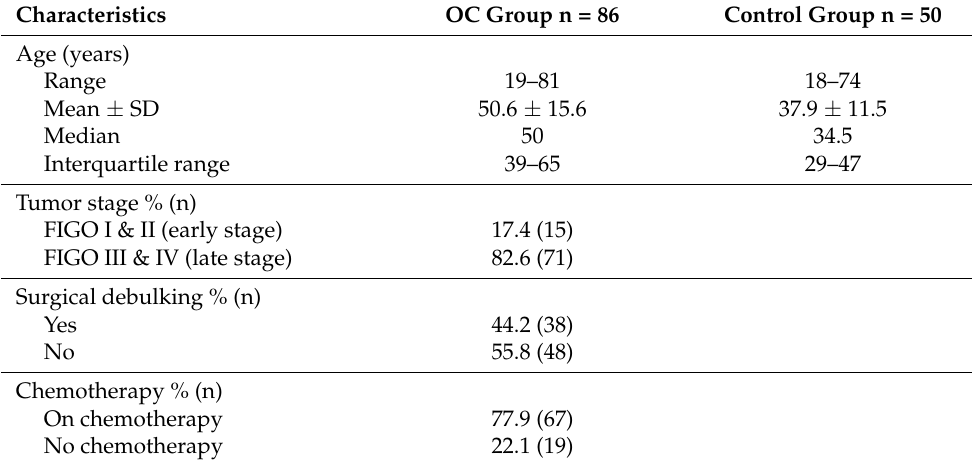
Table 1. Description of participants’ baseline demographic and clinical factors.